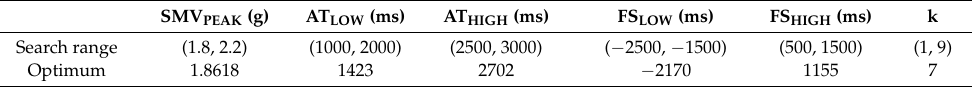
Table 5. Threshold ranges and values of Alg. 4 for the MobiAct